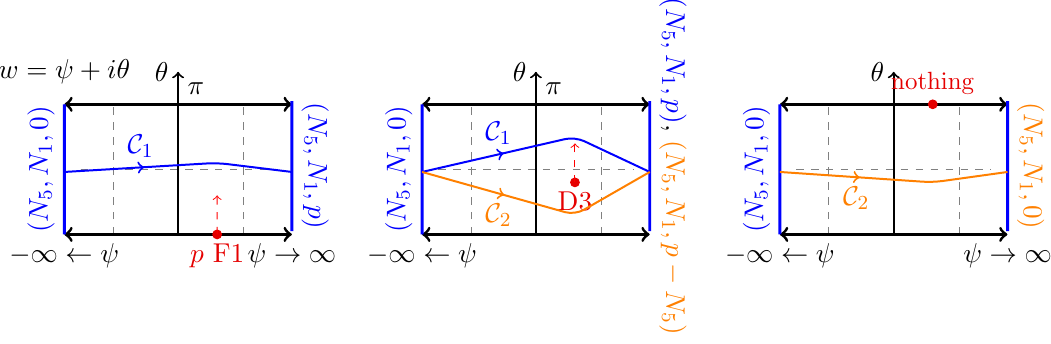
Figure 6 . Left: when comparing (cid:12)elds between the two asymptotic regions we follow contour C 1 . Note that the defect charge is absorbed by the CFT on the right. Middle: contour C 2 de(cid:12)nes another duality frame for the (cid:12)elds for which the right CFT carries no F1 charge. Right: in the frame C 2 we can have the defect move all the way to the south pole, where it turns into the trivial